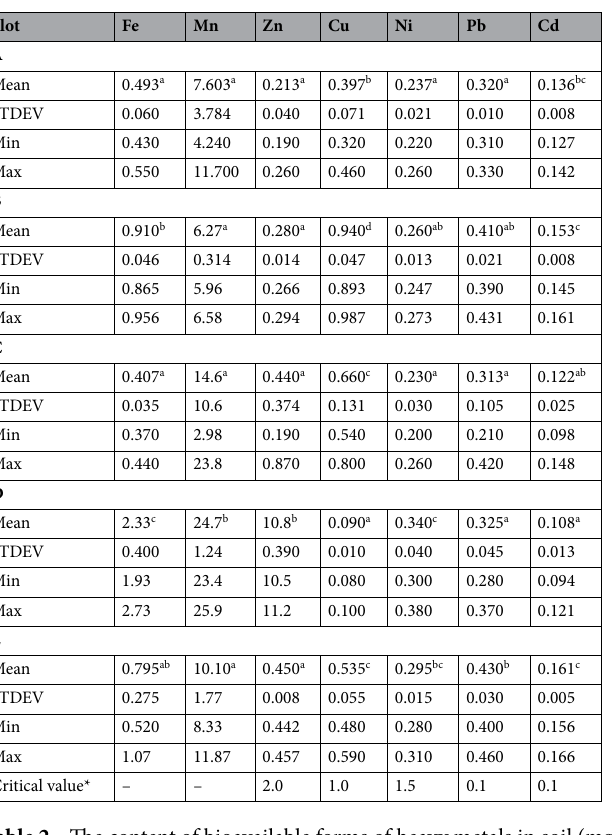
Table 2. The content of bioavailable forms of heavy metals in soil (mg/kg). *For soil extract by NH 4 NO 3 according to legislation valid in the Slovak Republic 31 . a–d Statistically significant differences between plots, P value < 0.05 of One-Way ANOVA analysis.